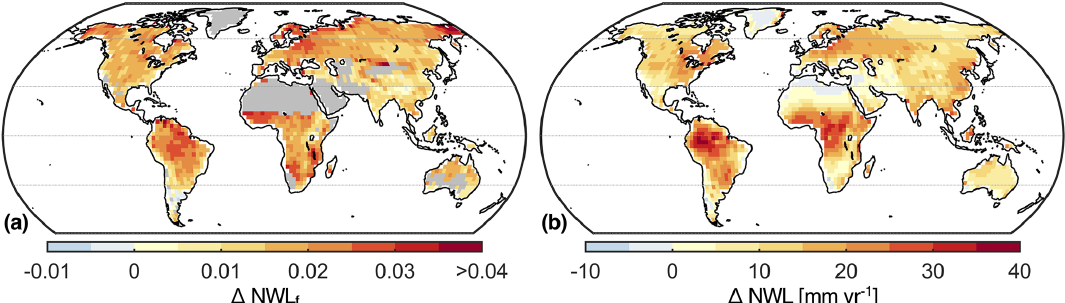
Figure 8. Multi-model mean of projected changes in NWL f (a) and NWL (b) for the period from 2081 to 2100 relative to the period from 1976 to 2005. Desert regions and Greenland are masked in panel (a) due to division by small numbers.